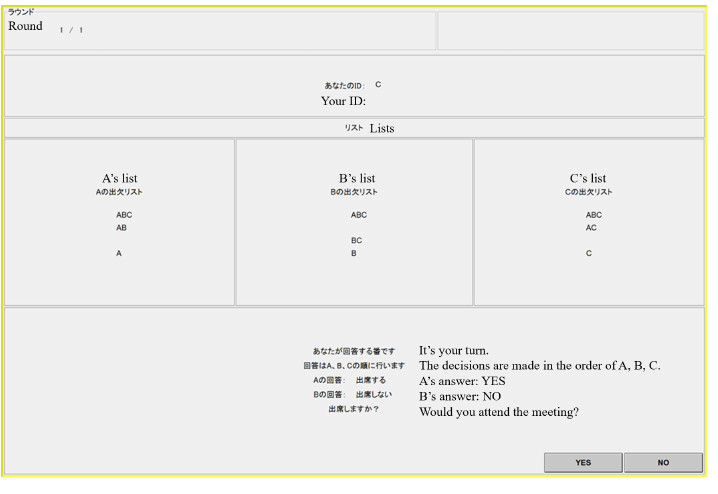
Figure A2. Treatment SEQ